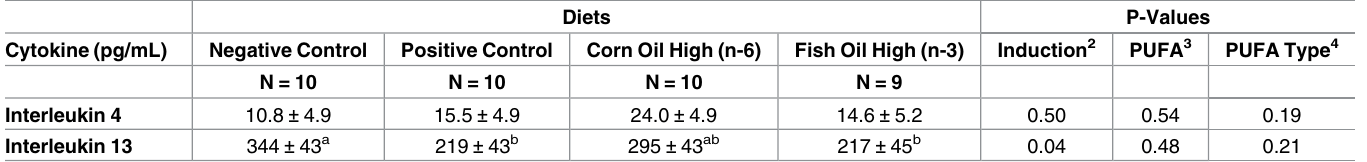
Table 5. Cytokine (IL-4 and IL-13) concentrations in BAL fluid of mice fed (n-3) or (n-6) PUFA enriched foods for 8 weeks and then sensitized and challenged with OVA for an additional 4 weeks compared with mice fed control food that were sensitized and challenged with saline (Negative Control) or OVA (Positive Control) 1